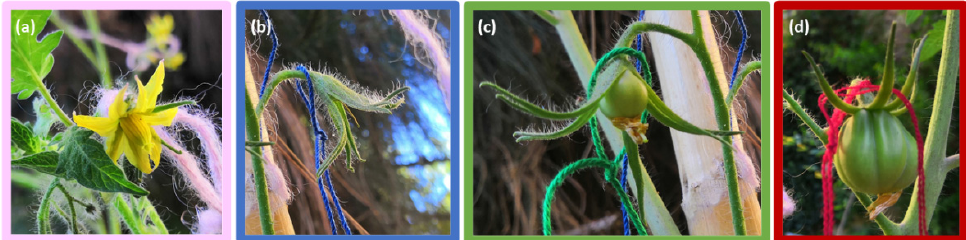
Figure 1. An example of marking made at various developmental stages on the same plant: ( a ) pink for opening flowers, ( b ) blue for fertilized flowers, ( c ) green for small green tomatoes, and ( d ) red for large unripe green tomatoes.